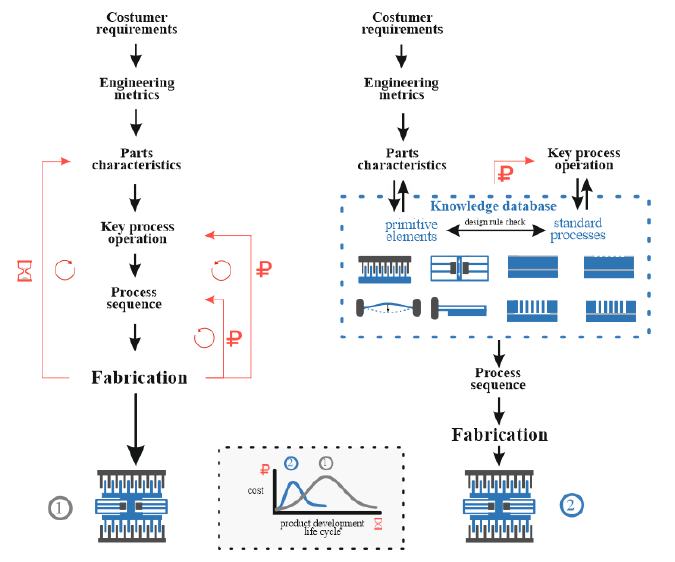
Fig. 12. Approaches to the development of MEMS